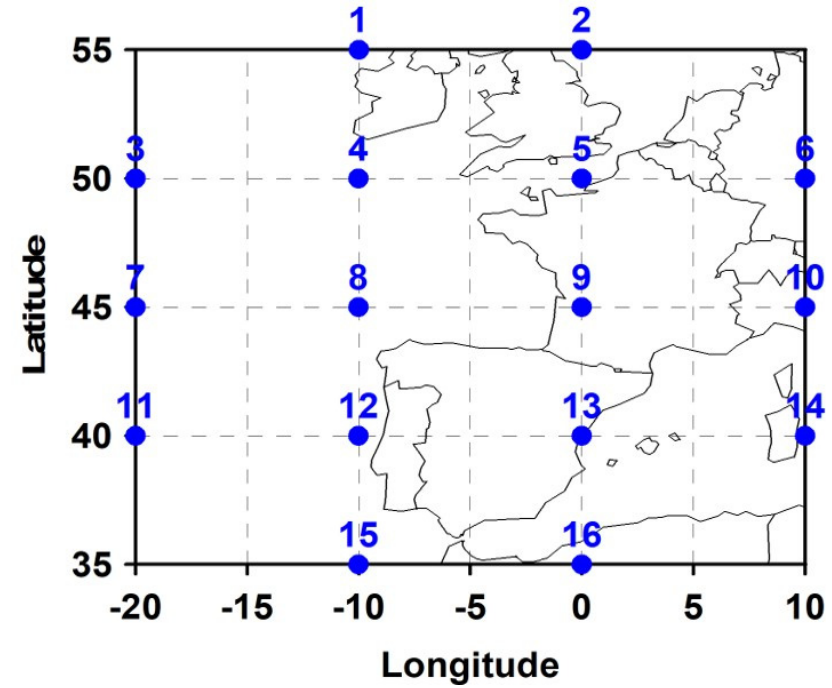
Figure C1. Grid points used to compute the flow indices. Figure A1. Grid points used to compute the flow